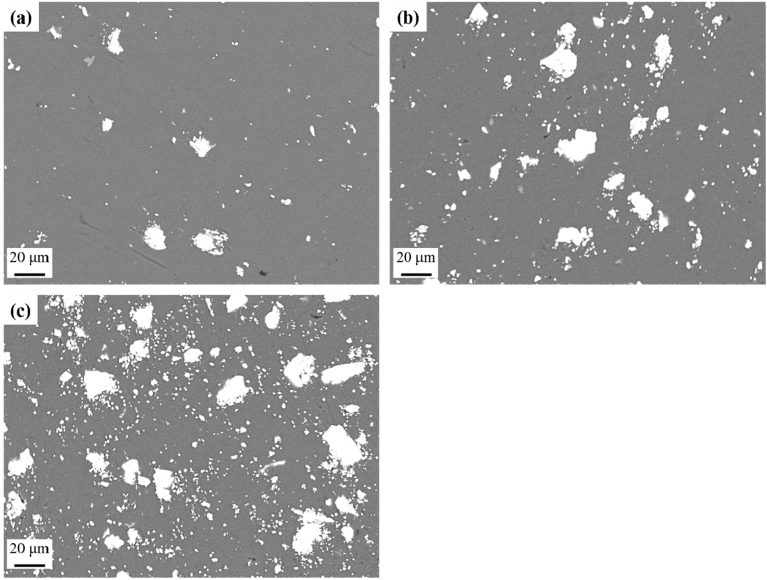
Figure 3. Microstructure of the produced composites (Back scattered electron mode): ( a ) Al ‐ 1 vol% HEA, ( b ) Al ‐ 3 vol% HEA, and ( c ) Al ‐ 5 vol% HEA.